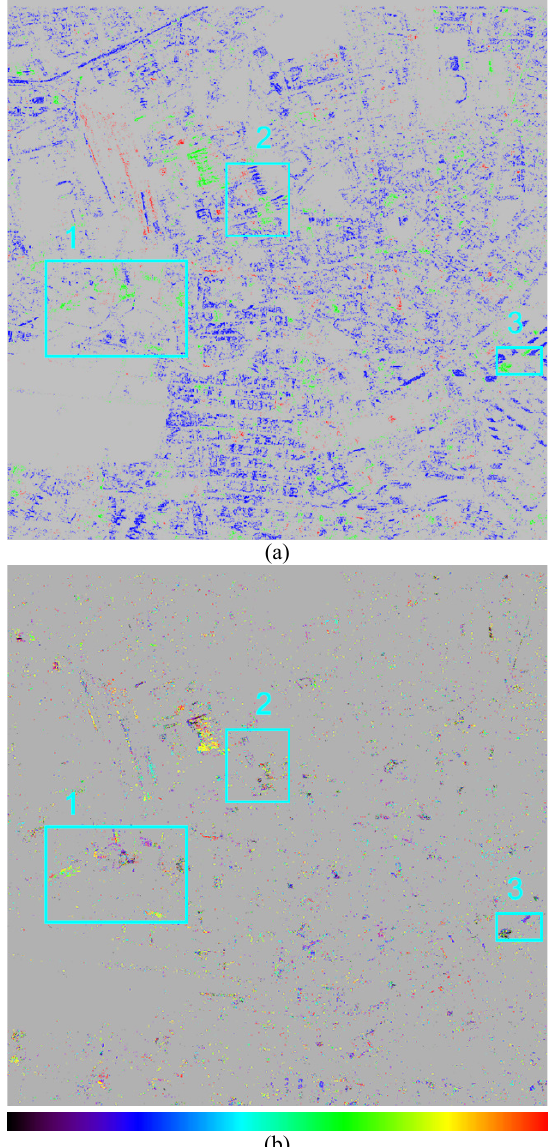
Figure 4. Spatiotemporal change detection result. Patches 1 to 3 are used for in-depth analysis. (a) Steady, disappearing, and emerging buildings represented by PS (blue, 41277/km 2 ), DBC (red, 2200/km 2 ), and EBC (green, 7180/km 2 ) points. (b) Disappearance and emergence dates: black to red, earliest to latest in 2013.